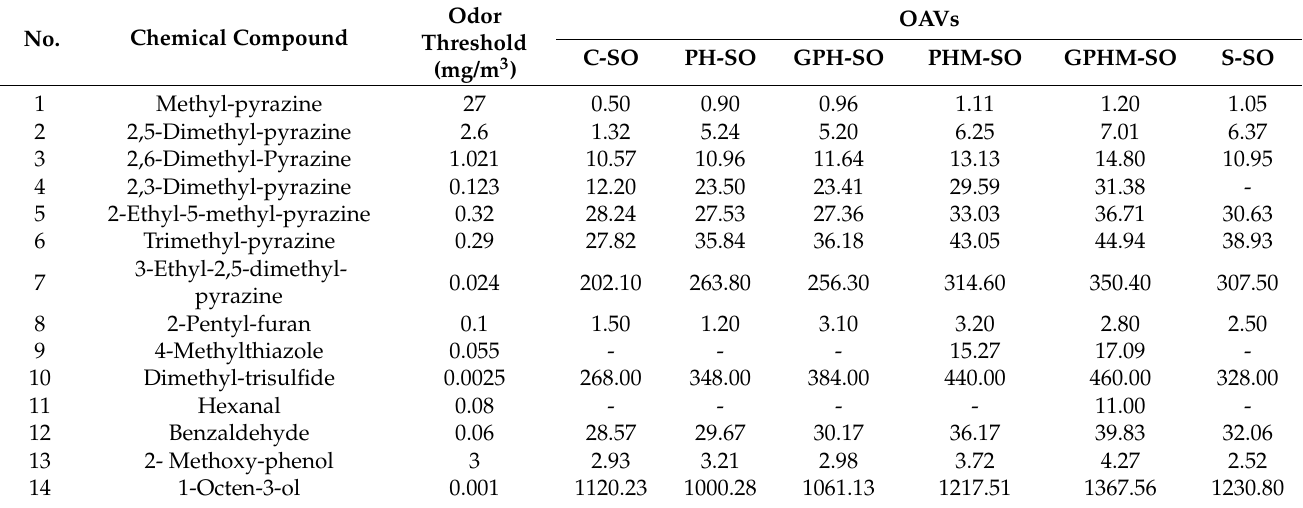
Table 5. Odor activity values (OAVs) of main volatile compounds in different